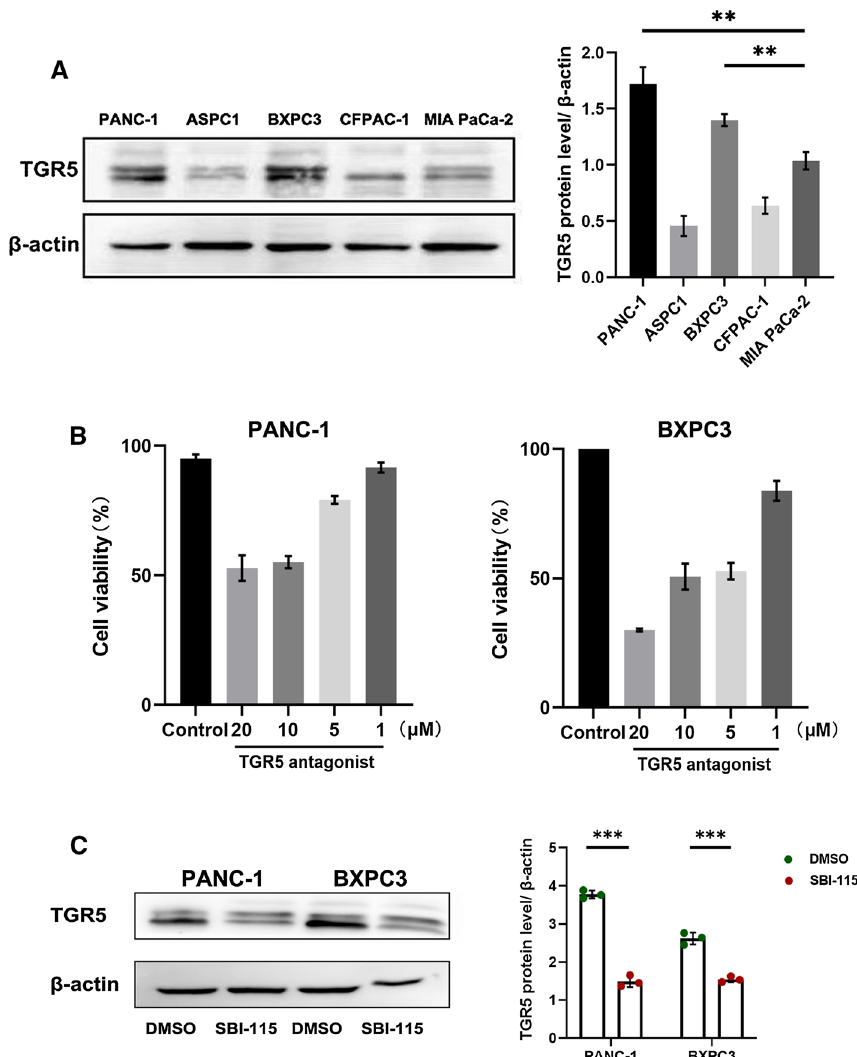
Fig. 1 SBI-115 can antago- nize the expression of TGR5 in pancreatic cancer cells. A The protein levels of TGR5 in five human pancreatic cancer lines (PANC-1, ASPC1, BXPC3, CFPAC-1, MIA PaCa-2); B The effects of different concen- trations of SBI-115 on the cell viabilities of PANC-1 and BXPC3 cell lines by using CCK- 8; C The result of Western blot showed that TGR5 expressions in SBI-115-treated PANC-1 and BXPC3 groups were weakened compared with that control groups. **P < 0.01, ***P <